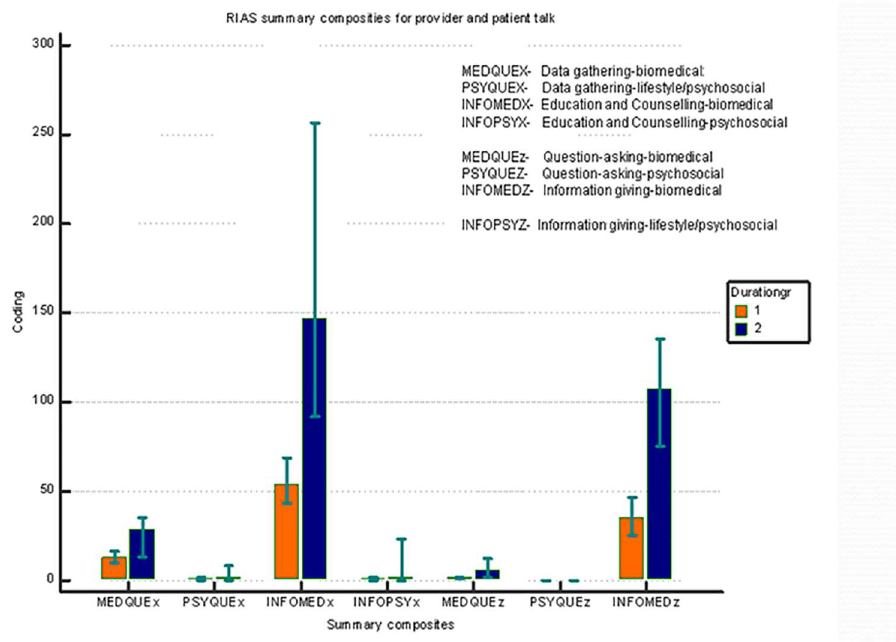
Fig 4. RIAS summary composite results for the medical and WCC visits by